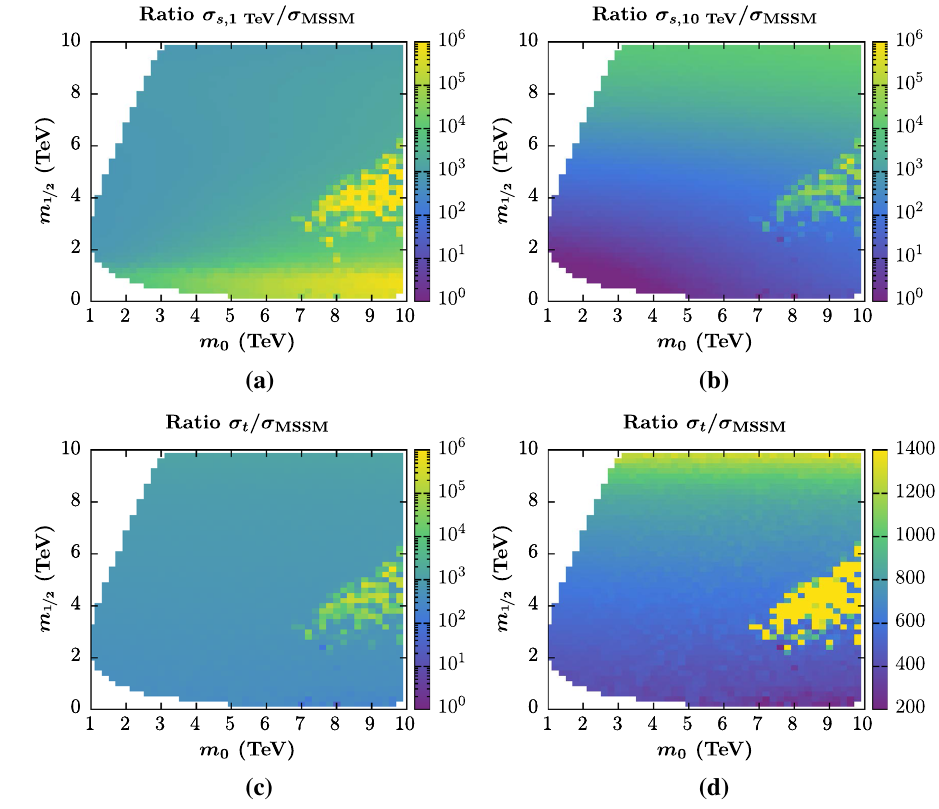
Fig. 6 Ratios of total cross sections for DM pair production in the simplified models to the ones in the MSSM, in the plane of the CMSSM parameters m 0 and m 1 / 2 , with all other parameters varied implicitly. Shown are the s -channel models with M V = 1 TeV ( a ) and M V = 10 TeV ( b ), and the t -channel model with a logarithmic ( c ) and a linear ( d ) colour scale, respectively. White regions denote points excluded in the parameter space where either the LSP is charged and therefore no DM candidate (top left corner) or where radiative electroweak symmetry breaking is not possible (bottom left corner). Rough edges are an interpolation